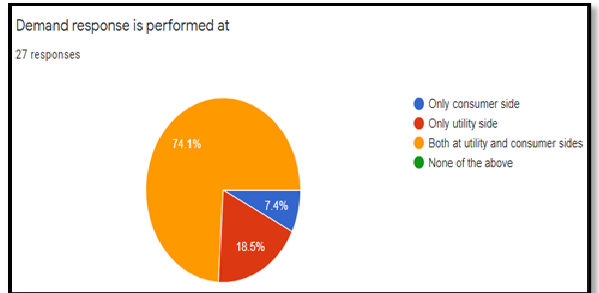
Figure 9. Response showing demand performance in consumer or utility side or